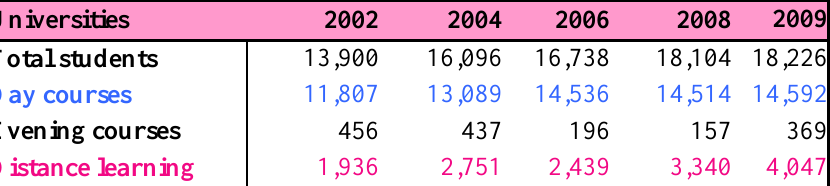
Total Students at University Level in